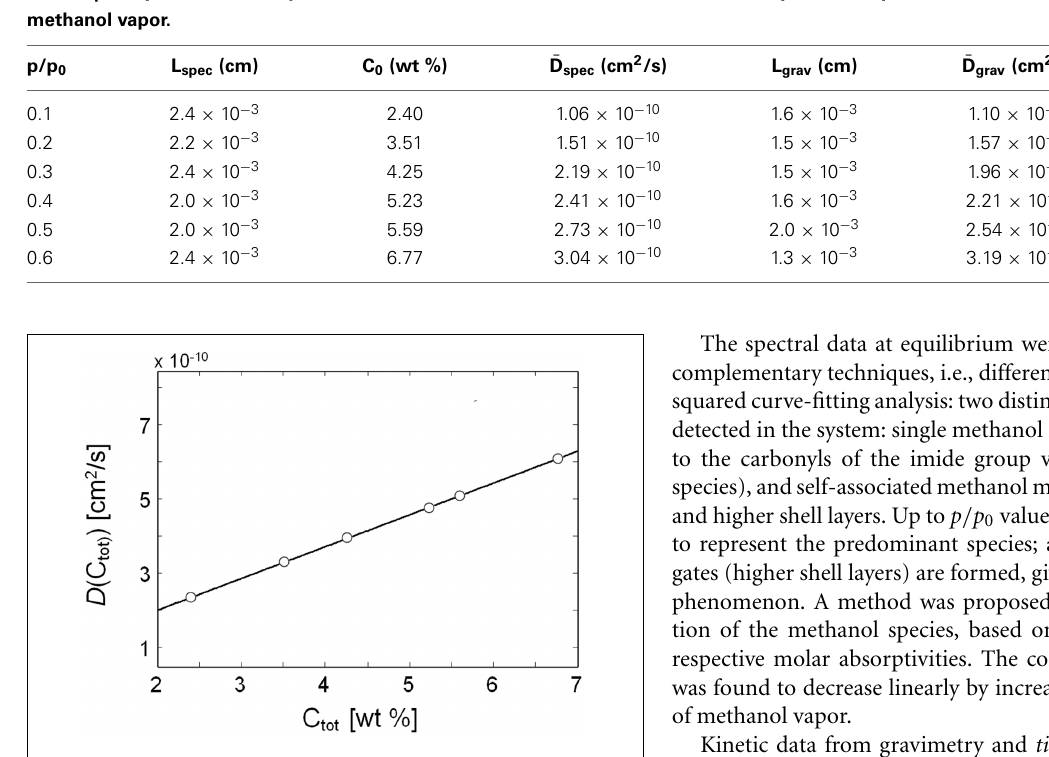
Figure 14 | Diffusivity of methanol vapor in PMDA-ODA as a function of the total concentration of methanol in the sample.